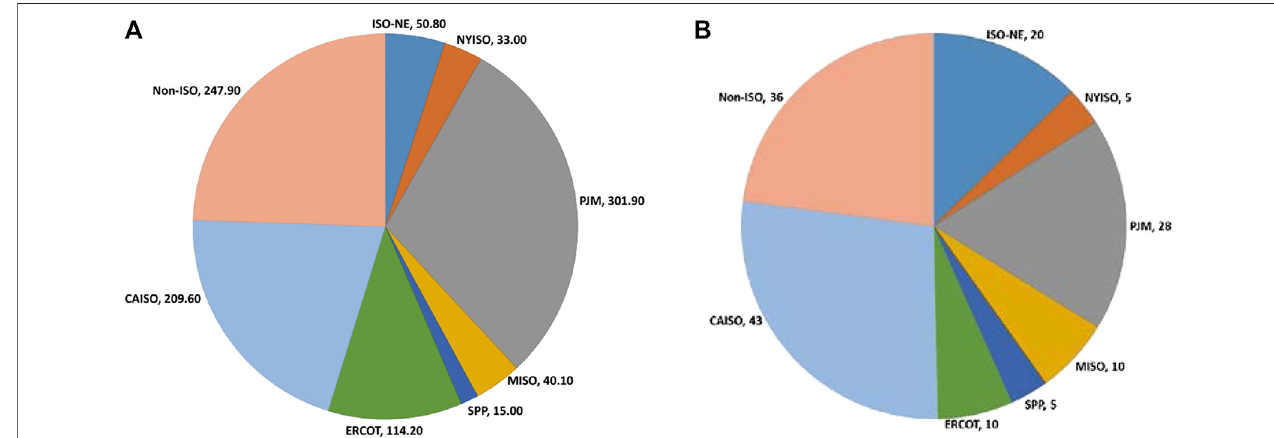
FIGURE 1 | Cumulative battery energy storage systems operating as electric power resources by ISO in September 2019, categorized by (A) installed nameplate capacity (MW) and (B) number of